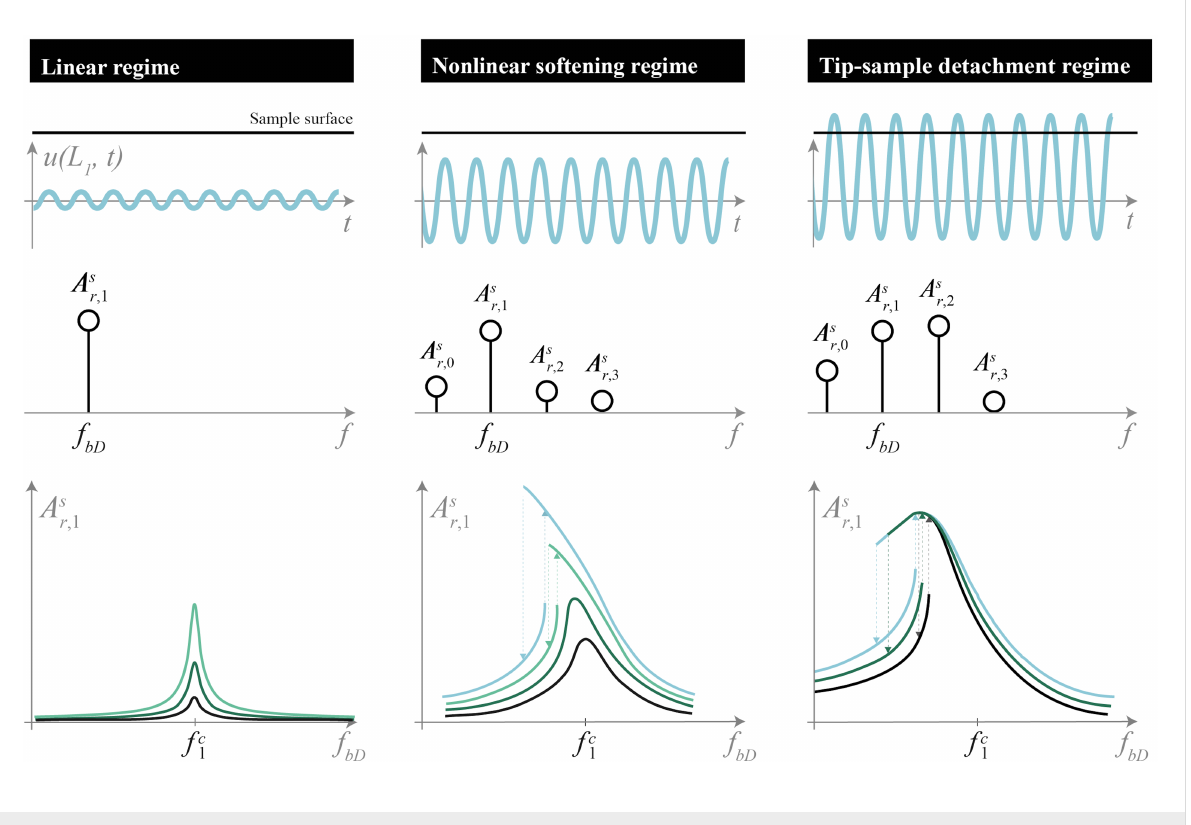
Figure 4: Infographic for summary of linear, nonlinear softening, and tip–sample detachment regimes for qualitative AFM cantilever behavior corre- sponding to low, moderate, and high drive amplitude excitation, respectively. The top plots depict representations of the AFM probe tip path in time indented below sample surface, the middle plots show representations of harmonic contributions to slope response amplitude of cantilever above probe tip, and the bottom plots provide representations of slope response first harmonic amplitudes versus drive frequencies at various drive ampli-